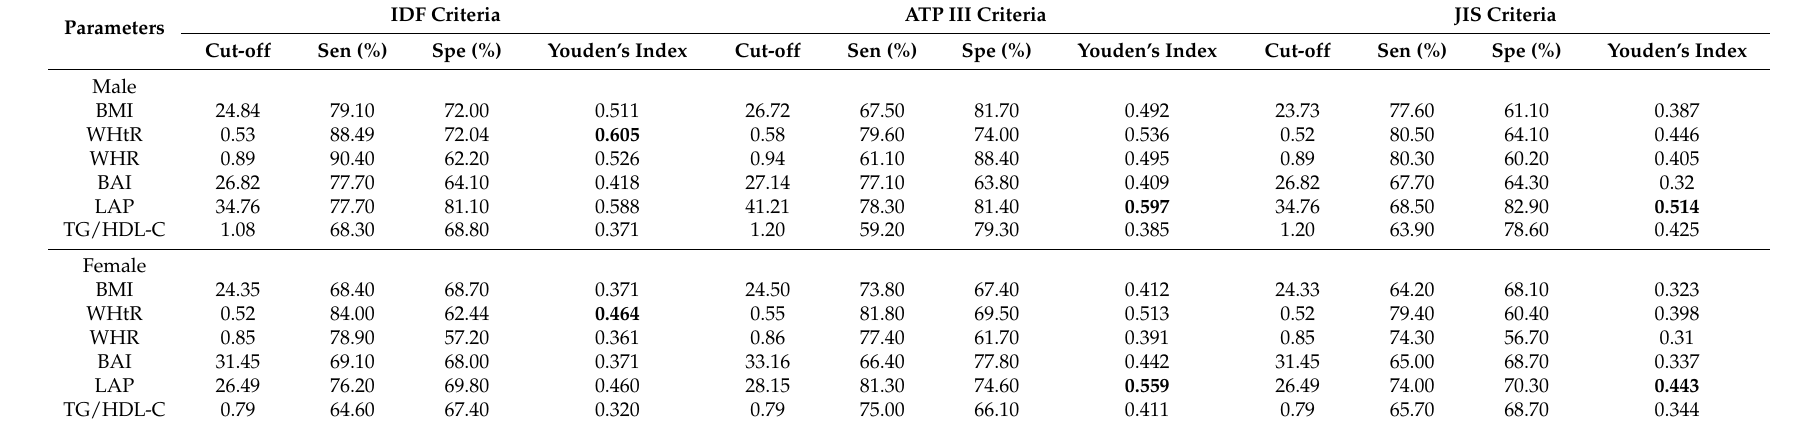
Table 3. The cut-off, sensitivity, specificity and Youden’s index of each variable for the screening of MetS in Kazakh males and females. Parameters